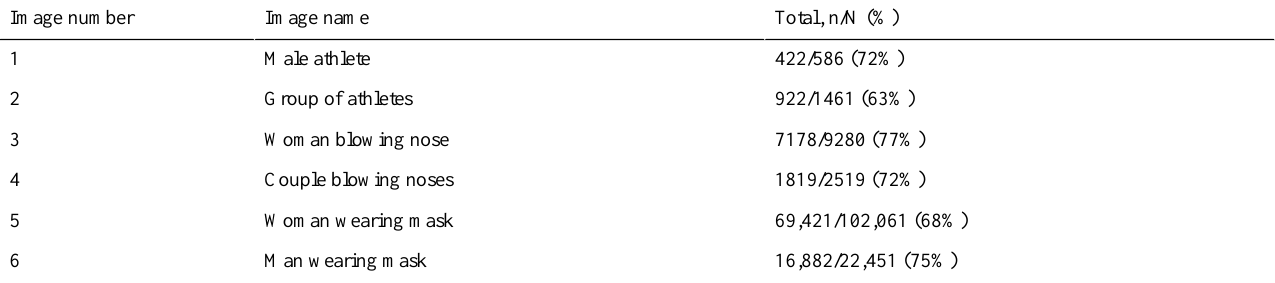
Table 1. The number of respondents who personally perceived COVID-19 as a high (score=4) or very high threat (score=5) to themselves based on a 5-point Likert-type scale for each ad image. No weighting has been